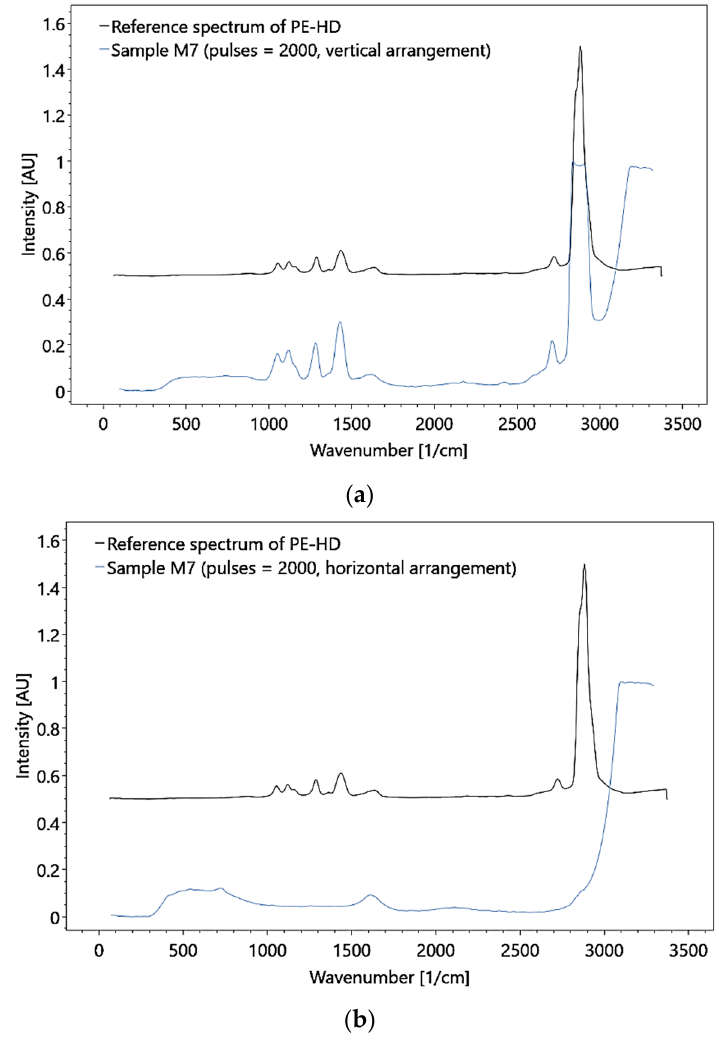
Figure 19. Raman analysis of the HDPE sample in the large flow cell, under ( a ) vertical and ( b ) horizontal arrangement, with a particle concentration of 1414.7 particles per 270 ml and 0.5 mm for the particle size.